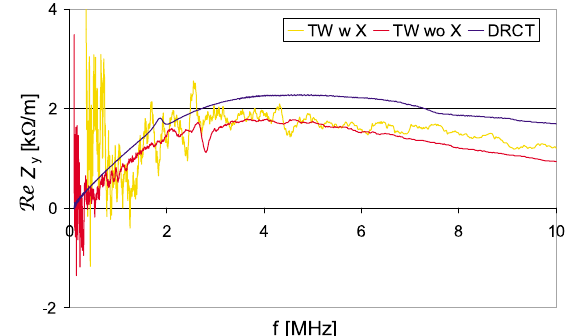
FIG. 10. (Color) Transverse impedance from wire and direct